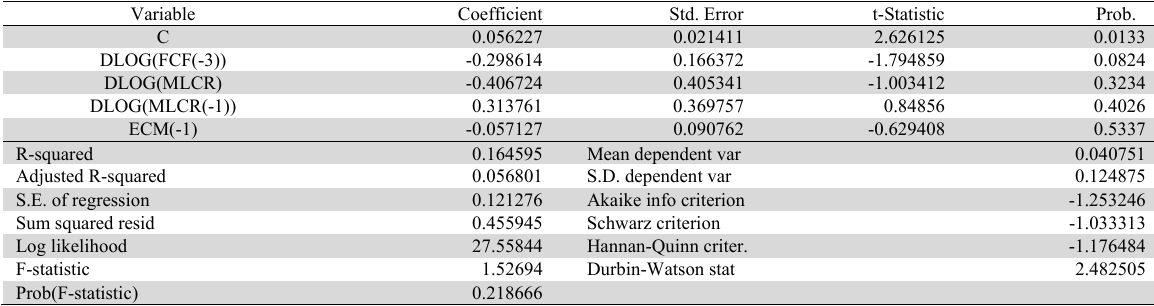
Error Correction Model